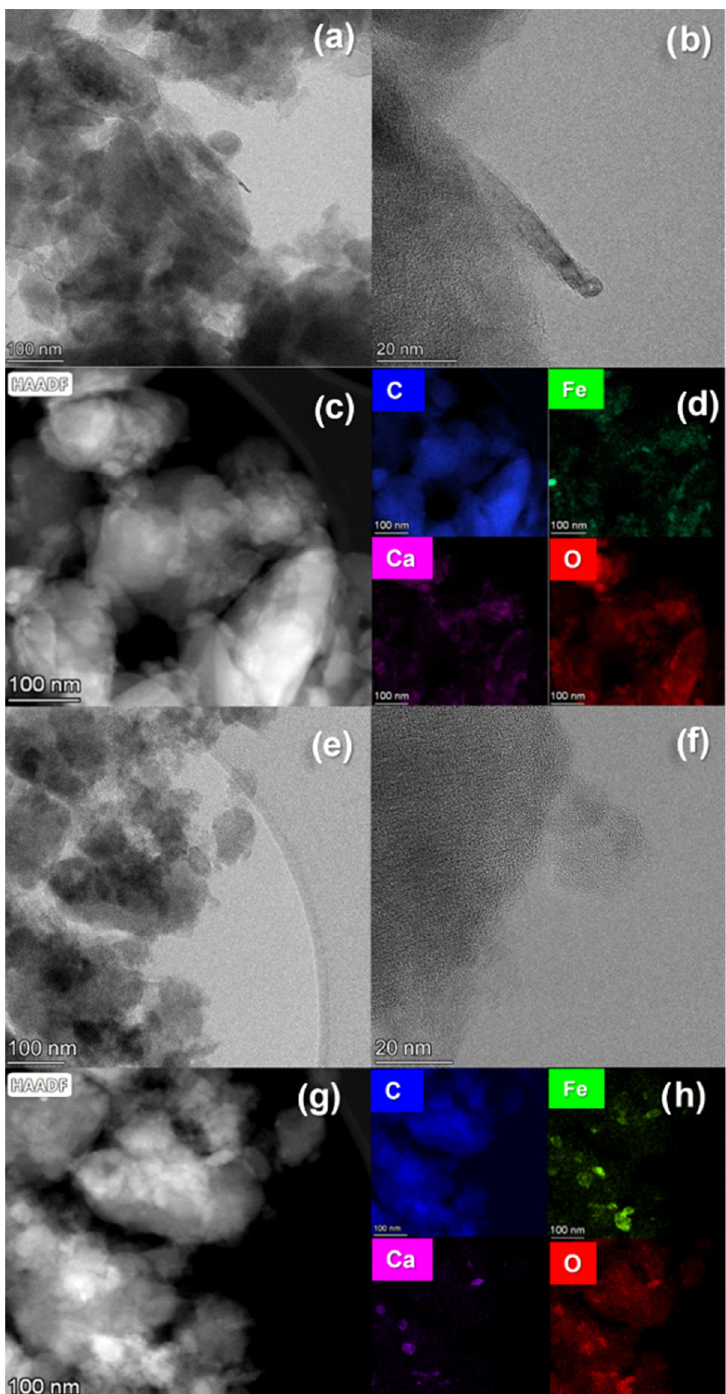
Figure 3. Electron microscopy investigation of cig_450 ( a – d ) and cig_750 ( e – h ). Low magnification HRTEM ( a , e ); high magnification HRTEM image ( b , f ); HAADF images ( c , g ); EDX maps of C, Fe, Ca and O ( d , h ).